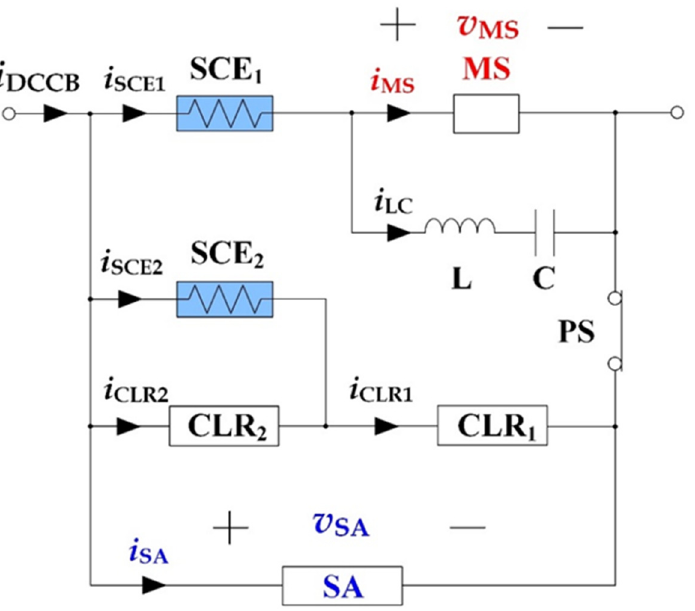
Figure 1. Structure of hybrid Direct Current (DC) circuit breaker using double quench; SCE: superconducting element; MS: mechanical switch; CLR: current limiting resistor/reactor; SA: surge arrestor; PS: power switch.